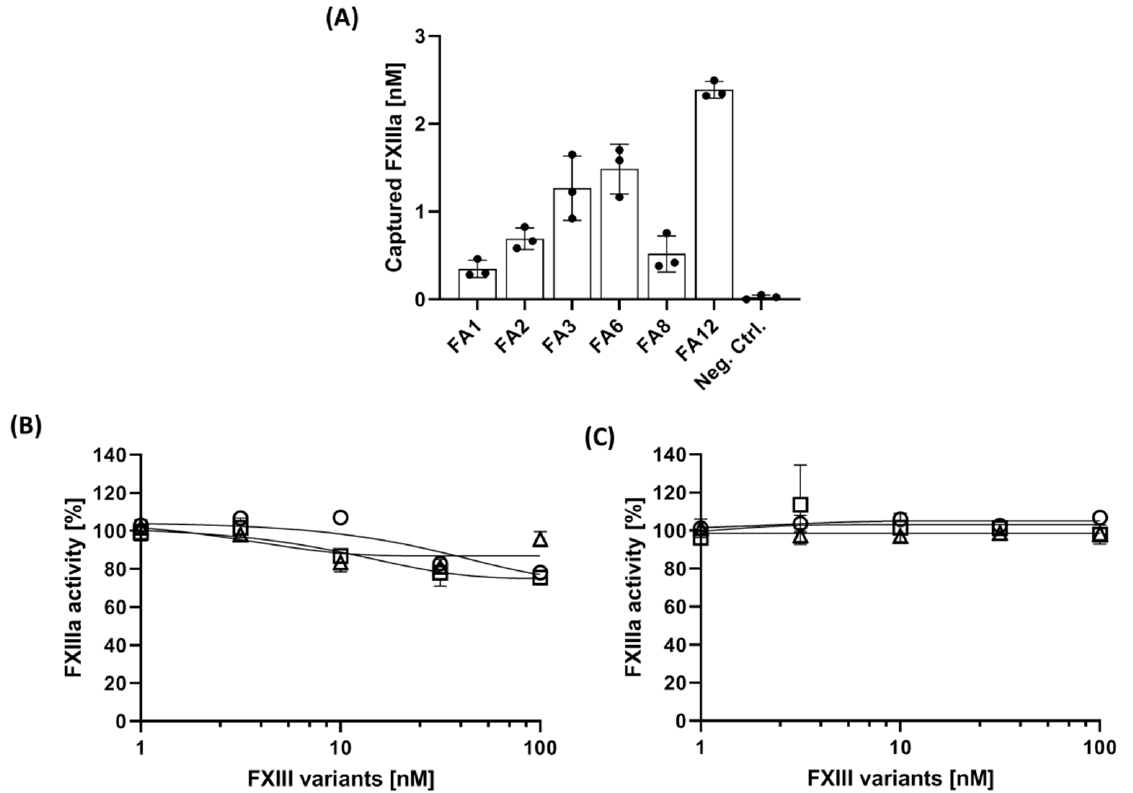
Figure 2. Determination of the capacity of aptamers in FXIIIa capturing. ( A ) FXIIIa (30 nM) was incubated in microtiter plates primed with each aptamer. Captured FXIIIa was quantified using the FXIIIa-specific fluorogenic peptide substrate. Subsequently, FXIIIa-capturing by the FA6 ap-tamer ( B ) and the FA12 aptamer ( C ) in the presence of increasing concentrations of FXIII, FXIII-A, and FXIII-B was determined. All results are shown as means with standard deviations of tripli-cates. ○ FXIII, □ FXIII-A, ∆ FXIII-B.